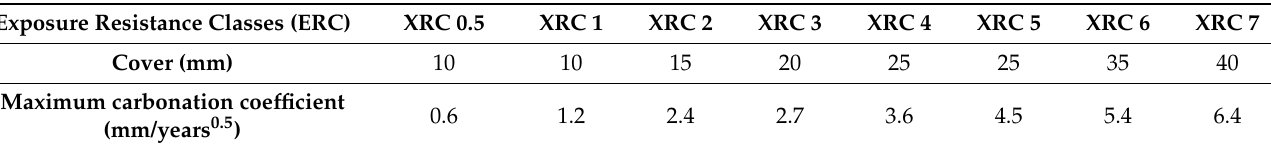
Table 8. Concrete cover (mm) and maximum mean value of carbonation coefficient (mm/years 0.5 ) required for exposure resistance classes (ERC) given for XC3 exposure